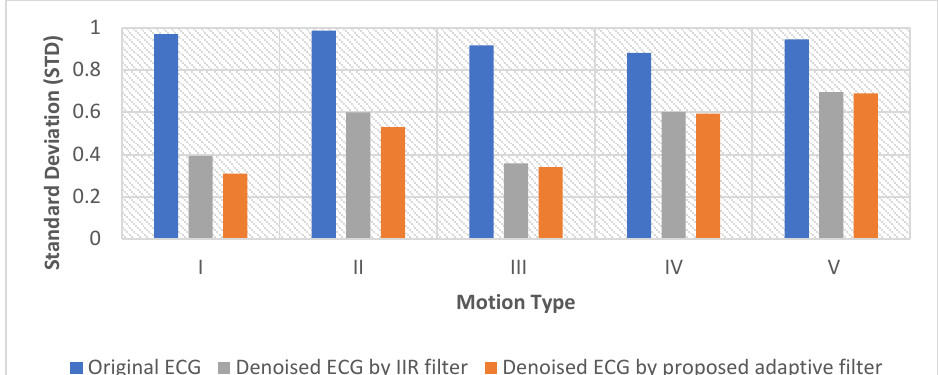
Figure 13. The performance of the IIR filter and the proposed method.